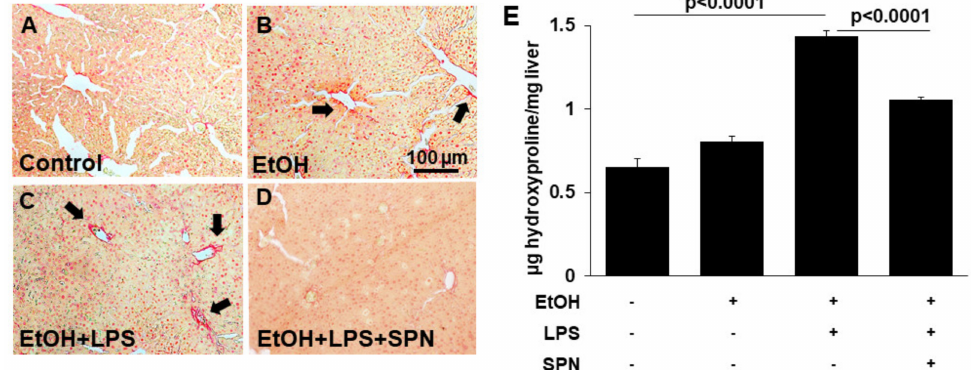
Figure 5. Spermidine prevents ethanol and and LPS-collagen deposition. Thick (4–6 µ m) sections from mouse livers treated in the absence (control) or presence of ethanol (EtOH), LPS and/or spermidine (SPN) as indicated were stained with Sirius red to monitor collagen deposition ( A–D ). Labeling was only observed in sections from mice treated with ethanol alone or additionally treated with LPS ( B , C ). Bar = 100 µ m Total hydroxyproline was detected colorimetrically from control or treated mice as an additional indicator of collagen deposition ( E ). For each experimental condition, four mice were analyzed ( n = 4). Values are plotted as µ g hydroxyproline detected per mg of liver. The values in E are means of triplicate experiments ±